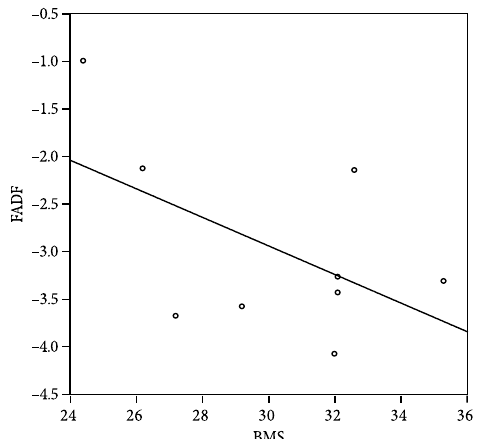
Fig. 5 . Relationship between black market share (BMS) and FADF